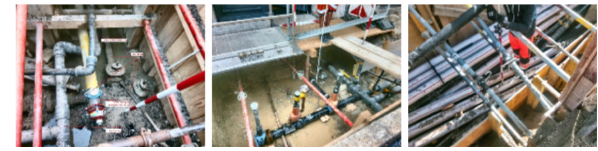
Figure 1: An example of open excavations that are to be surveyed, showing overlapping objects and